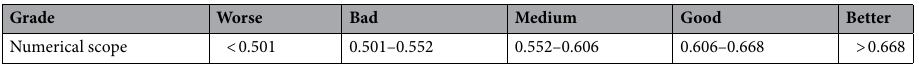
Table 7. Mining area eco-environmental quality evaluation and grading.